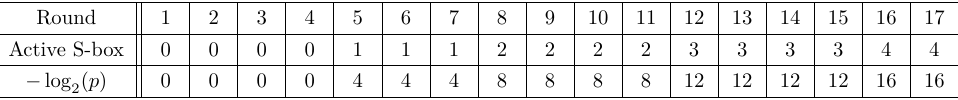
Table 8: Related-key differential properties of PIPO -256.